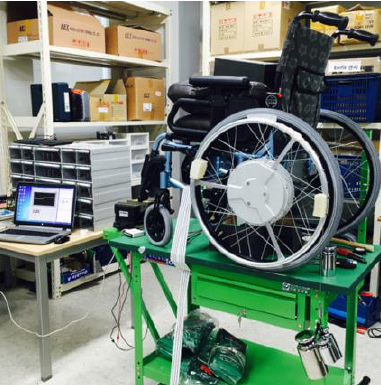
Figure 12. Picture of the experiment dropping various weights.